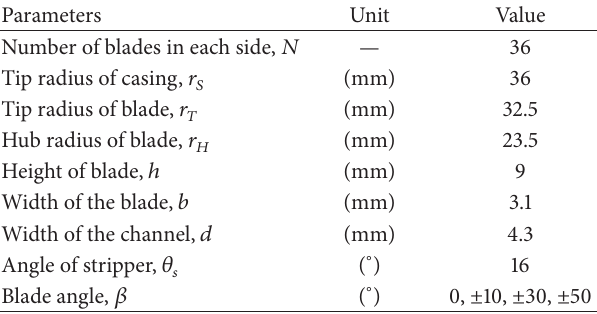
Figure 1: Schematic of the regenerative pump. Table 1: Geometric specifications of regenerative pump.